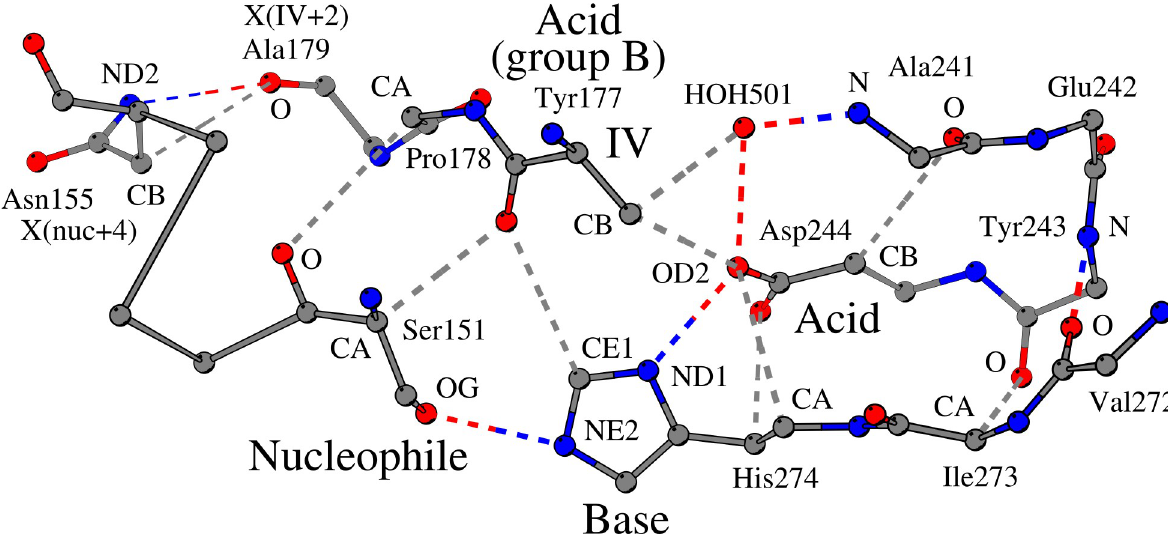
Fig 2. Coordination of the catalytic nucleophile-histidine pair and the catalytic histidine-acid pair in the carboxylesterase SshEstI (PDB ID:3WJ1). The catalytic nucleophile (“Nucleophile”, Ser151 in SshEstI) is hydrogen bonded (OG/Ser151 –NE2/His274) to the catalytic histidine (“Base”, His274 in SshEstI) as part of the standard interaction network of the residues of the catalytic machinery. However, three additional conserved interactions ensure the fine turning of the two catalytic residues next to each other: The main-chain oxygen atom of Tyr177 that is located at the C-terminus of strand β 6 (termed and shown as “IV”) forms two weak hydrogen bonds: one with the catalytic nucleophile (O/Tyr177 –CA/ Ser151) and another with the catalytic histidine (O/Tyr177 –CE1/His274); a third contact (O/Ser151 –CA/Pro178) is formed between the catalytic nucleophile and Pro178 (located ahead of position IV) and coordinates the catalytic nucleophile. Thus, these three interactions support the optimal arrangement of the catalytic nucleophile-histidine pair. The catalytic histidine (His274) interacts (ND1/His274 –OD2/Asp244) with the catalytic acid (“Acid”, Asp244 in SshEstI) and is further supported by two weak hydrogen bonds: OD2/Asp244 –CA/His274 and OD1/Asp244 –CB/His274. Interactions of the catalytic acid zone that are associated with the coordination of the catalytic histidine and other contacts located nearby the catalytic site are shown. Gray dashed lines, weak hydrogen bonds; colored dashed lines, standard hydrogen bonds.